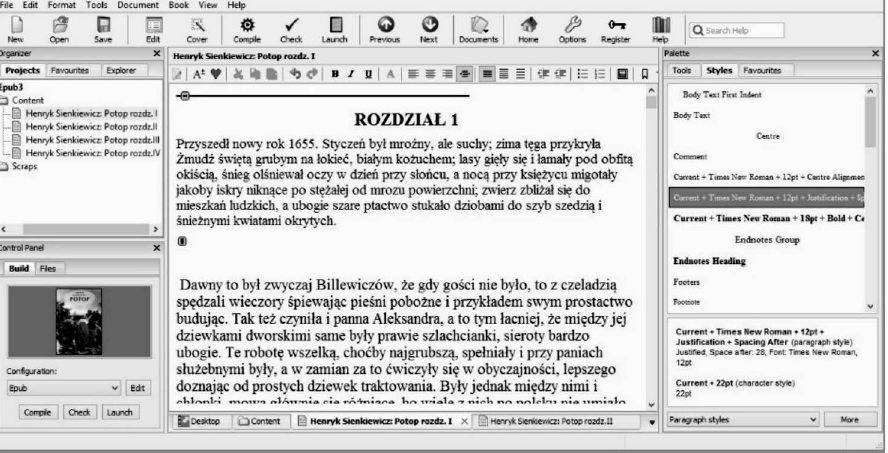
Figure 1. Jutoh user